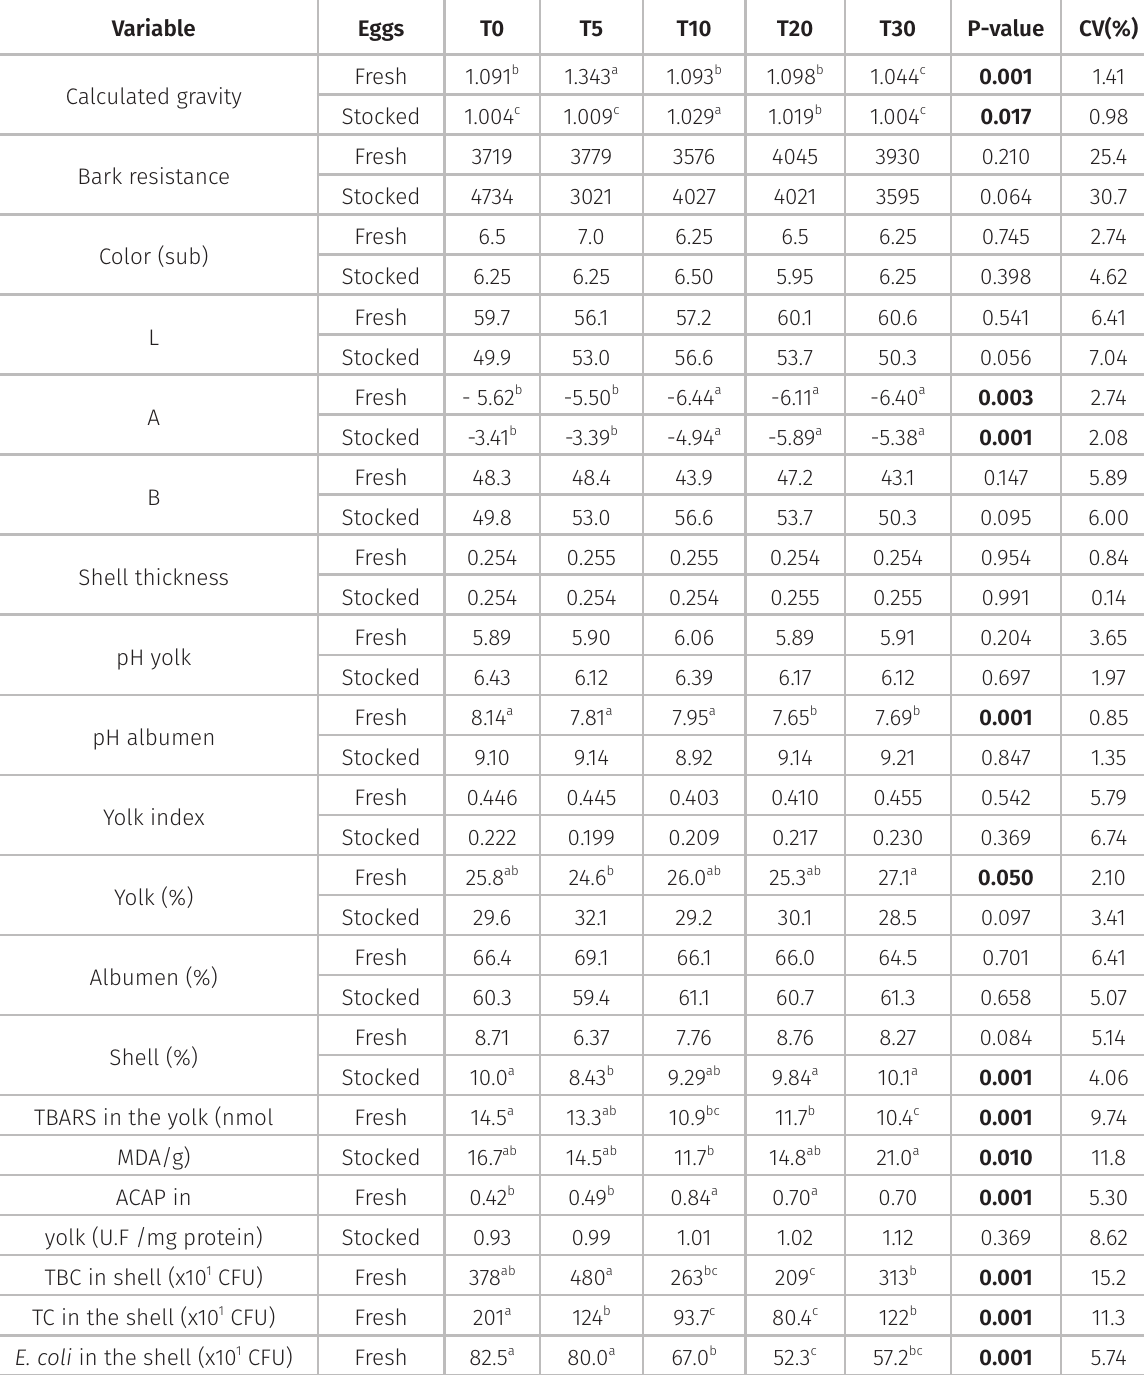
Table II. Egg quality of fresh eggs (days 21) and stocked eggs by 21 days from laying hens fed with differing propolis